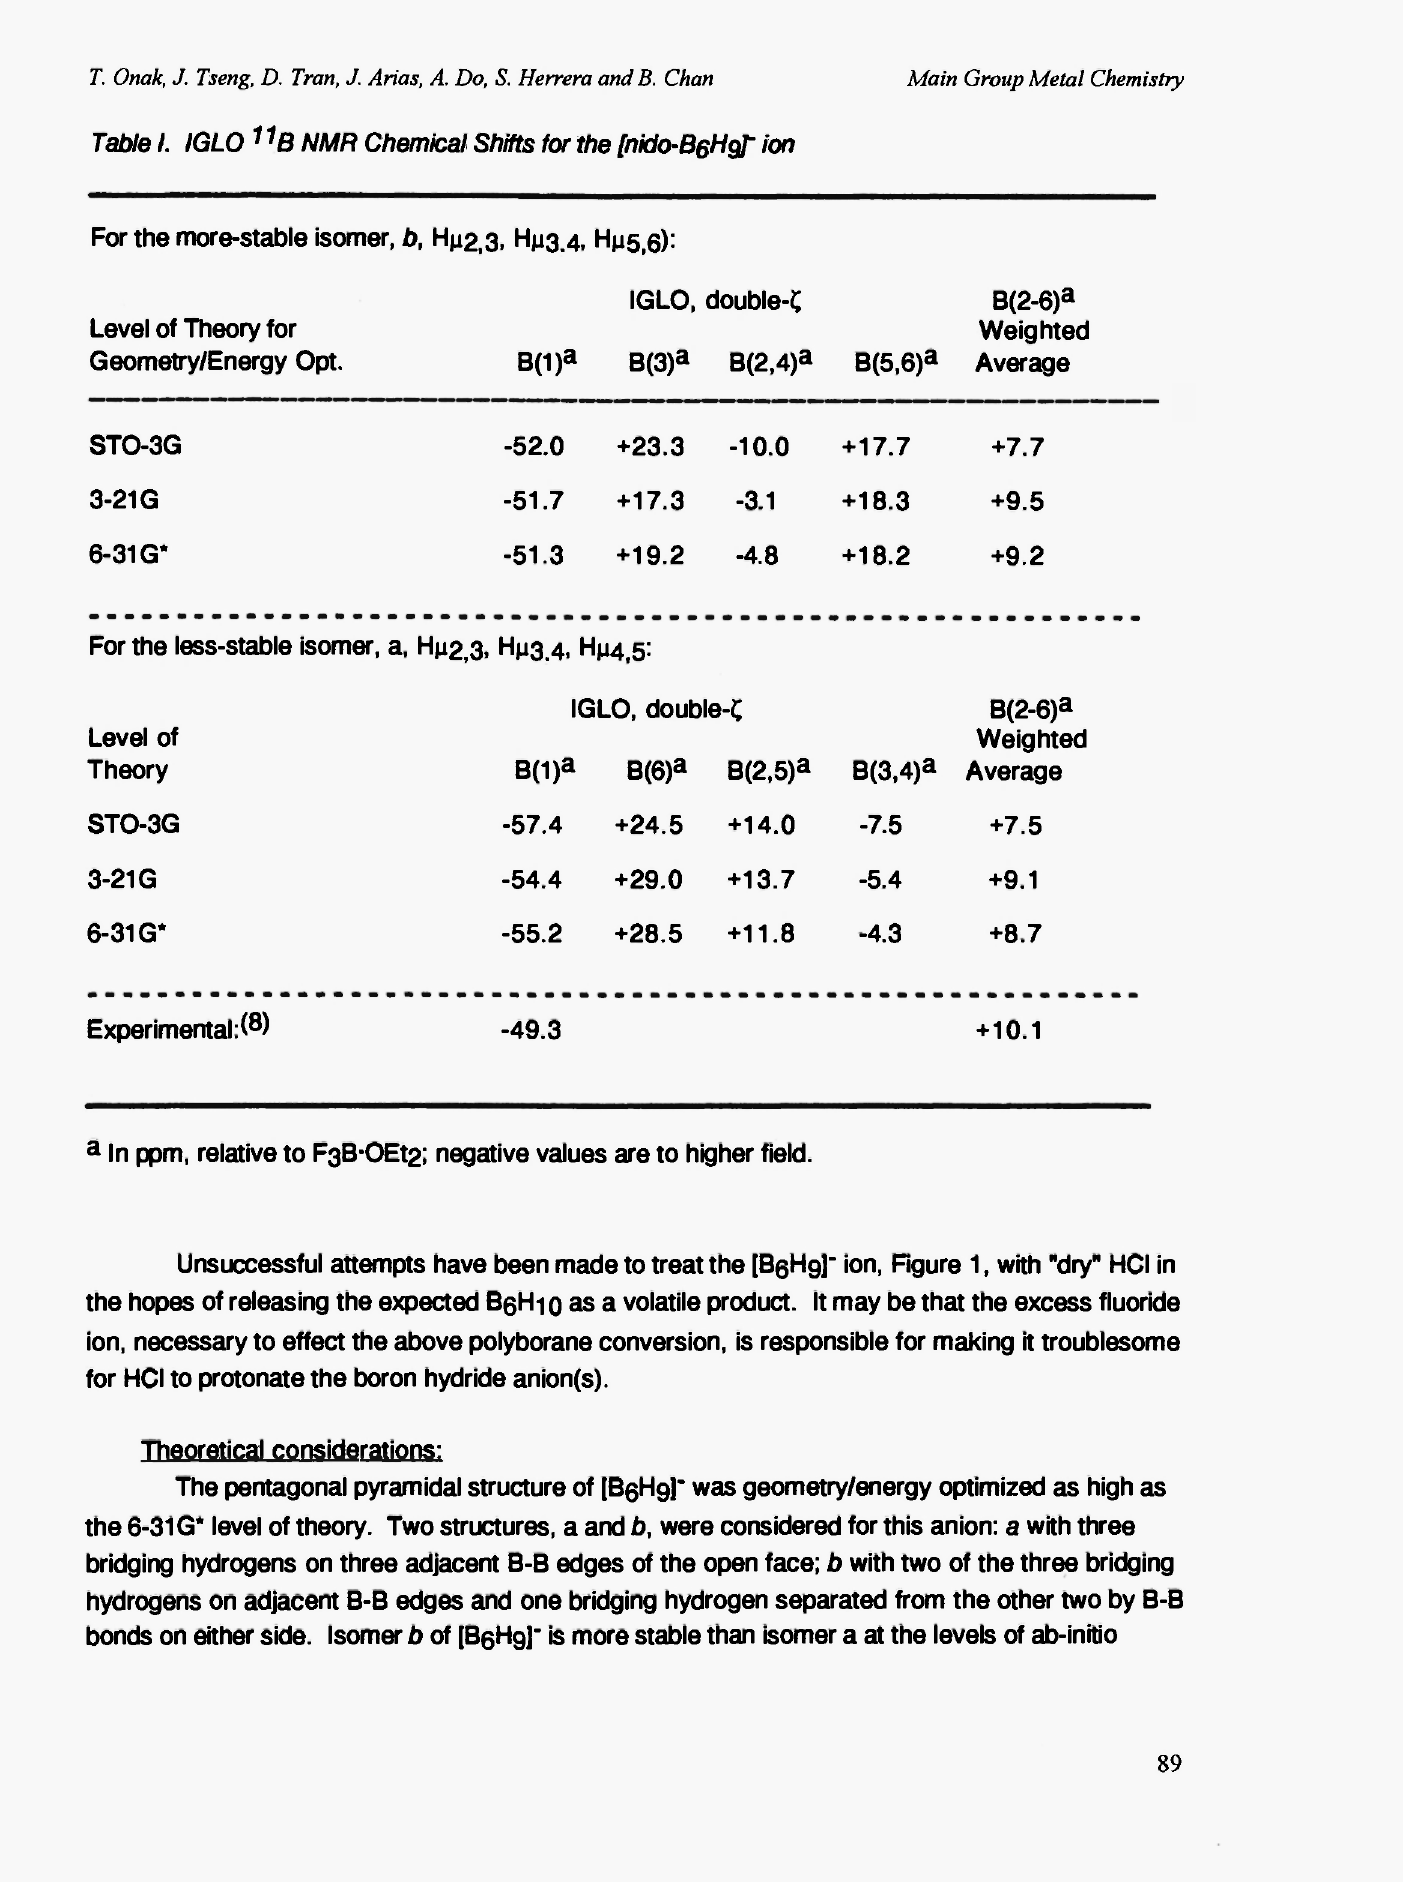
For the more-stable isomer, b, Ημ2,3, Ημ3 4, Ημδ,β): IGLO, double-ζ B(2-6) a Level of Theory for Weig hted Geometry/Energy